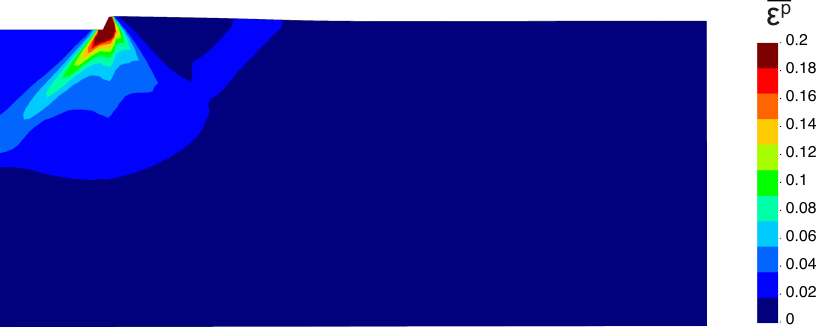
Figure 7. Geometry, material parameters and loading conditions of the strip footing problem.